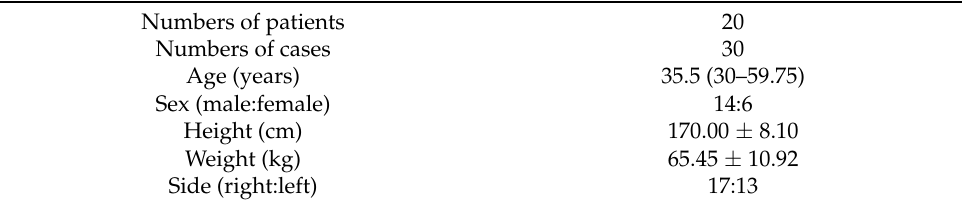
Table 1. Demographic characteristics of the